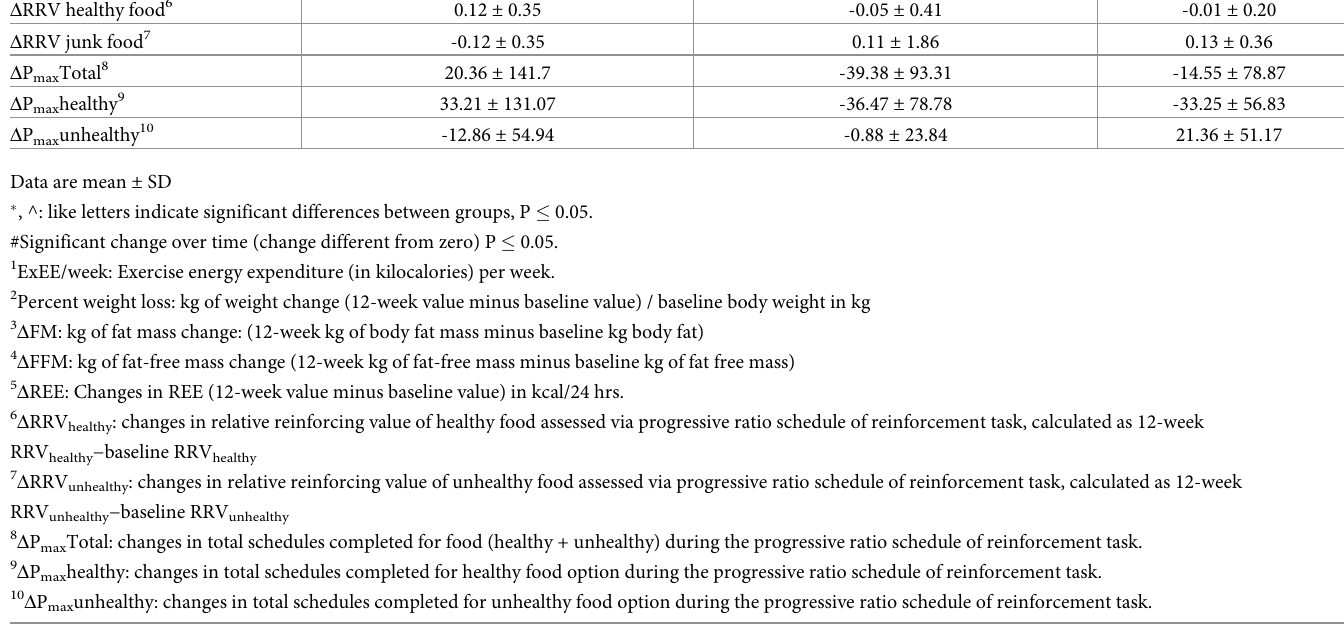
Table 3. Resulting data from the 12-week exercise intervention between groups that exercised either six or two days per week and a sedentary control group.